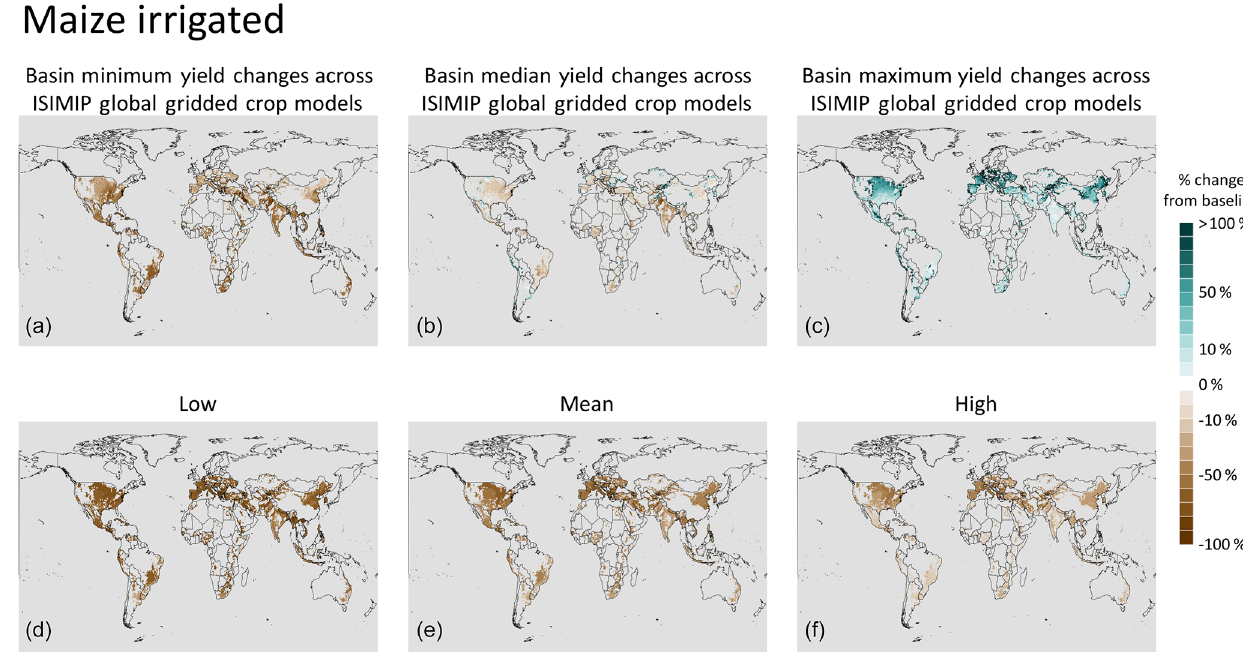
Figure 14. (a, b, c) Grid-cell-specific minimum (a, d) , median (b, e) , and maximum (c, f) yield change across the ISIMIP GGCMs for irrigated maize. (d, e, f) The low, mean, and high Persephone v1.0 yield changes in each grid cell for irrigated